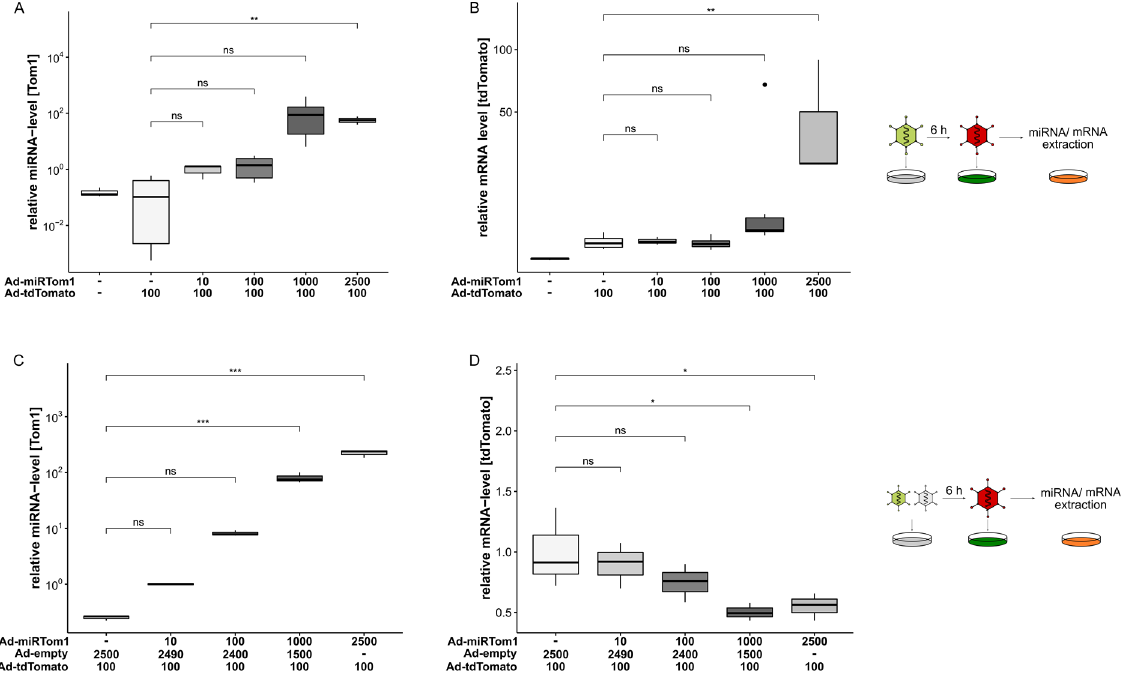
Figure 3. Dose-dependent expression of miRNA and targeting. A549 cells were transduced with Ad-tdTomato (MOI 100) and escalating MOIs of Ad-miRTom1. Expression levels of miRTom1 and target RNA were analysed in quantitative PCR. ( A , C ) Expression of CMV-driven miRNA (miRTom1) was scalable and correlated with physical adenoviral vector particles used for transduction (C: MOI 100: 9.7-fold expression over MOI 10; MOI 1000: 72.4-fold expression over MOI 10; MOI 2500: 220.2-fold expression over MOI 10; r 2 = 0.98). ( B ) Escalating doses of Ad-mirTom1 resulted in increased mRNA levels for tdTomato (44.5 ± 39.9, p = 0.006). ( D ) Complementation of applied physical Ad-miRTom1 vector particles with Ad-empty to an MOI 2500 resulted in dose-dependent downregulation (up to 50% reduction, p = 0.02) of target mRNA. Significance values were calculated with Dunnett’s test. MOIs (multiplicity of infection) were applied as indicated. ns, p > 0.05; *, p < 0.05; **, p < 0.01; ***, p < 0.001.